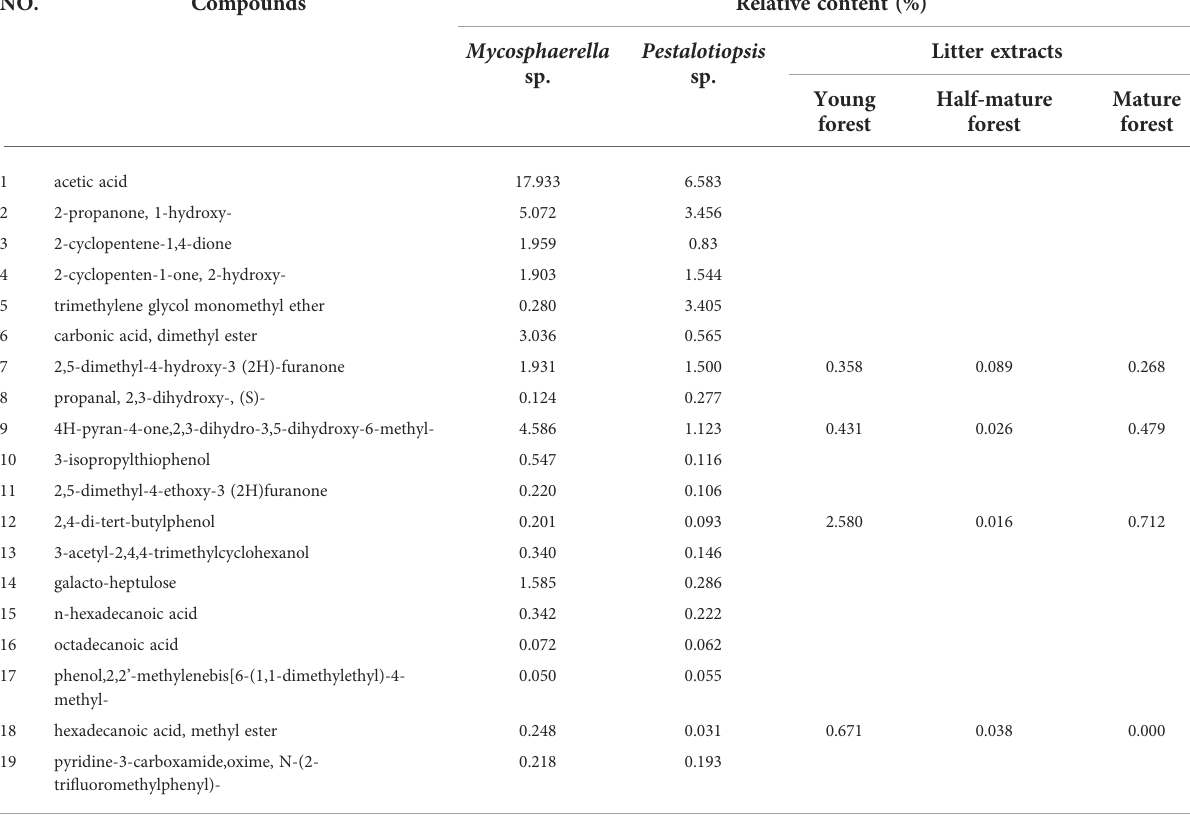
TABLE 1 Common secondary metabolites of Mycosphaerella sp. and Pestalotiopsis sp. compared with the chemical composition of litter extracts.